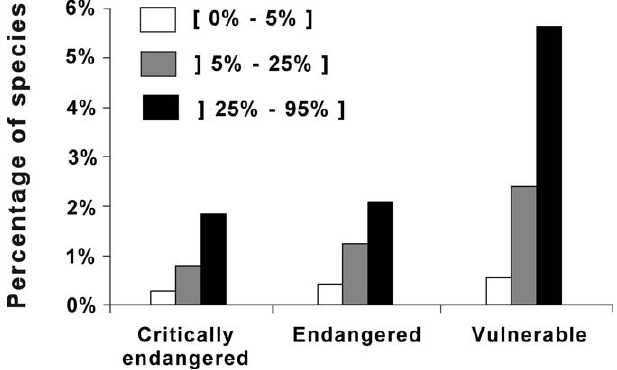
Figure 2. Percentage of Threatened Species for the Three Invasion Levels Threatened species were identified from the IUCN Red List (vulnerable, endangered, critically endangered). We calculated the percentage of threatened species, listed in the IUCN Red List, for the three invasion levels considered in Figure 1A. Each invasion level expessed as the percentage of non-native species. ([ 0%–5% ], ]5%–25%], ]25%–95%]) account for 8,363, 2,257, 1,241 native species and 544, 240, 271 river basins, respectively. doi:10.1371/journal.pbio.0060028.g002 PLoS Biology |